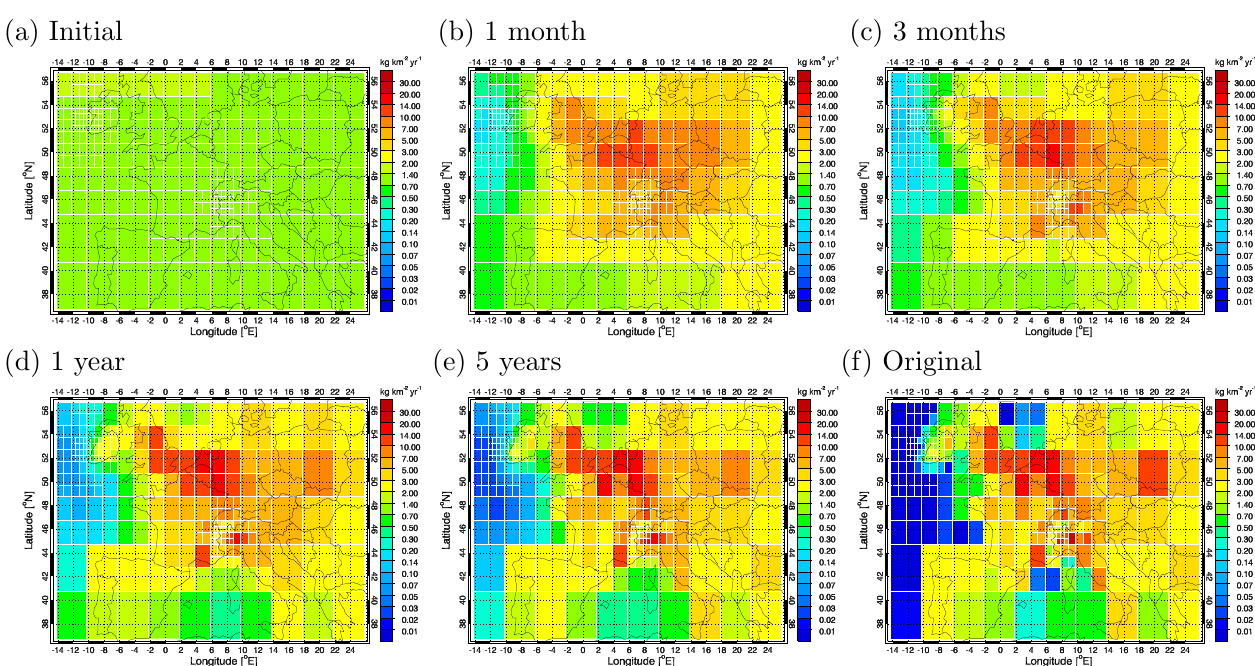
Fig. 5. Evolution of emission field for a simulation with noise-free synthetic observations. The original (true) emission field is shown in panel (f) for reference.